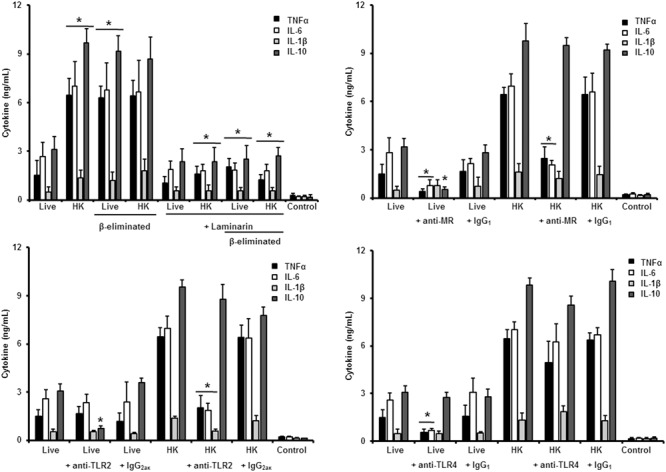
Cytokine production by human PBMCs stimulated with S. brasiliensis yeast-like cells. As Figure 6, but yeast-like cells were used. ∗P < 0.05, when compared with untreated cells.